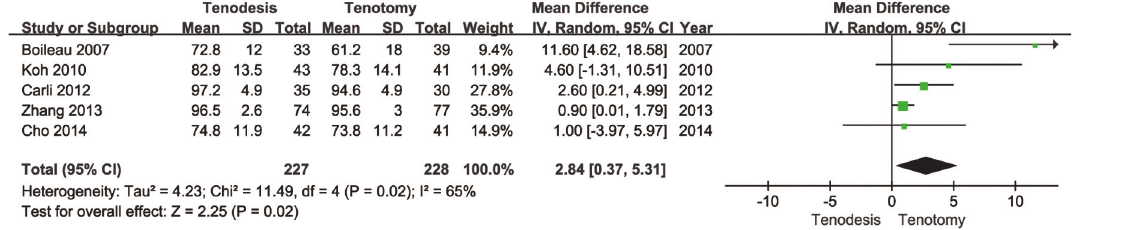
Fig 2. Forest plot to assess Constant score between two treatment strategies.